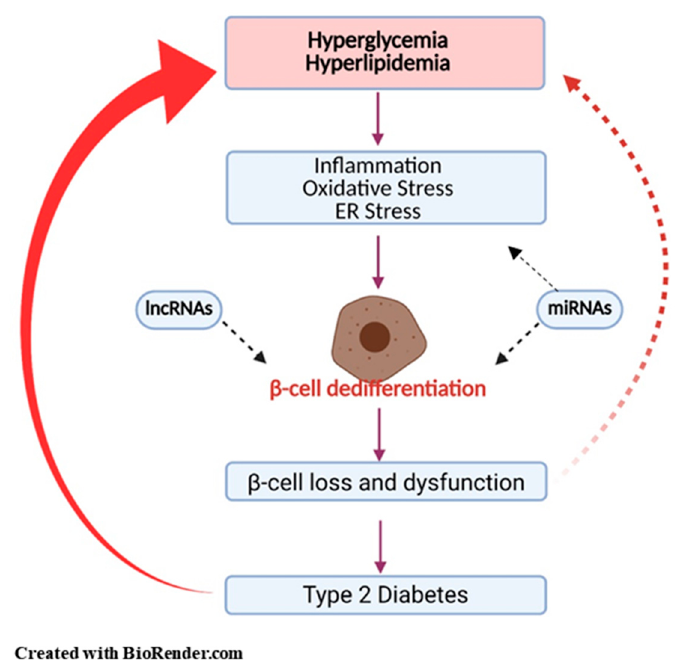
Figure 1. Pancreatic β -cell dedifferentiation in type 2 diabetes mellitus. High glucose and lipids induce inflammation, oxidative stress, and endoplasmic stress, which in turn leads to β -cell dysfunction through β -cell dedifferentiation. MicroRNAs and long non-coding RNAs induce β -cell dedifferentiation through various mechanisms: (1) recruitment of epigenetic modifiers, (2) regulation of transcriptional and post-transcriptional stages, (3) control of mRNA degradation. Loss of β -cell function and mass is a major hallmark of the development of type 2